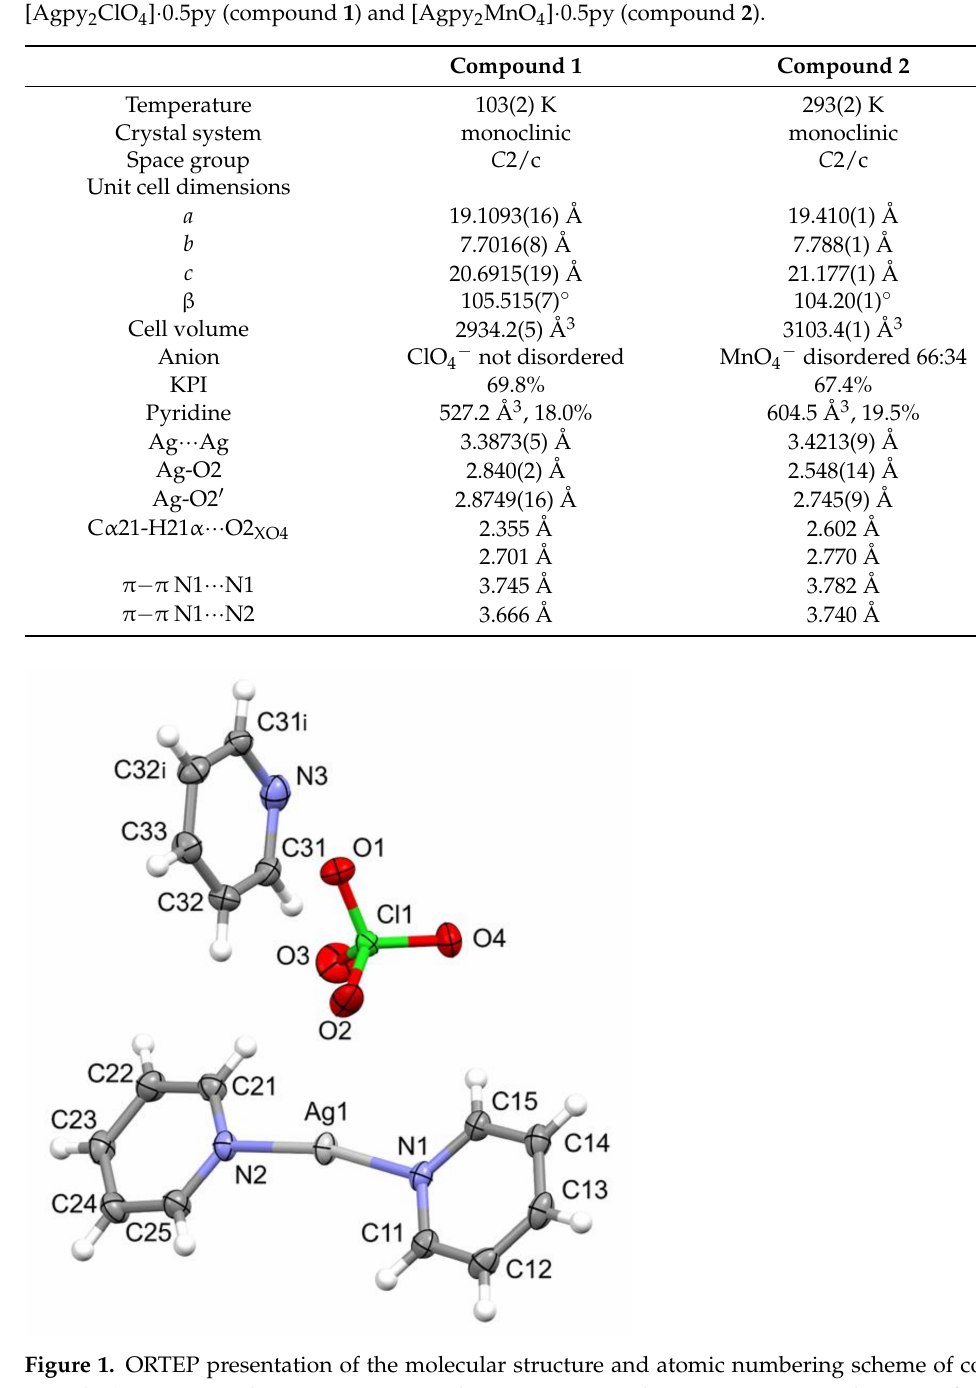
Figure 1. ORTEP presentation of the molecular structure and atomic numbering scheme of com- pound 1 (symmetry codes to generate equivalent atoms C31i and C32i were − x + 1 and y, − z + 1/2 + 1, respectively). The displacement ellipsoids are drawn at the 50% probability